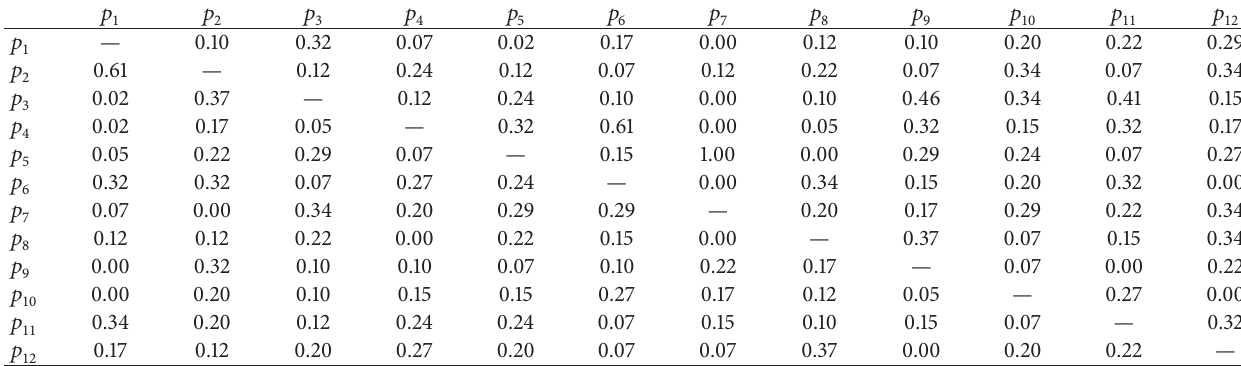
Table 7: Standardized initial information of collaborative indicators 𝐶 2 of candidate units.